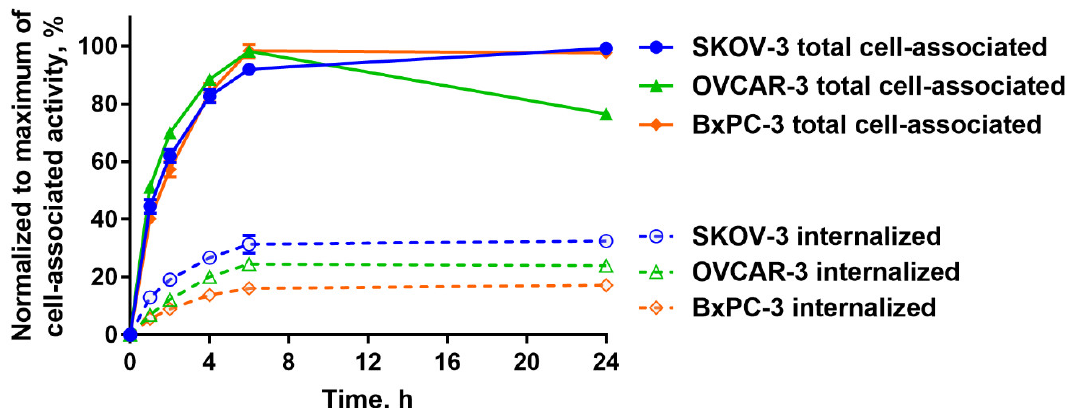
Figure 4. Cellular processing of [ 125 I]I-PIB-Ec1 by OVCAR-3, SKOV-3 ovarian cancer cells, and BxPC-3 pancreatic cancer cells over 24 h continuous incubation. Data are shown as mean ± SD ( n = 3); when error bars are smaller than symbols, they might not be visible.